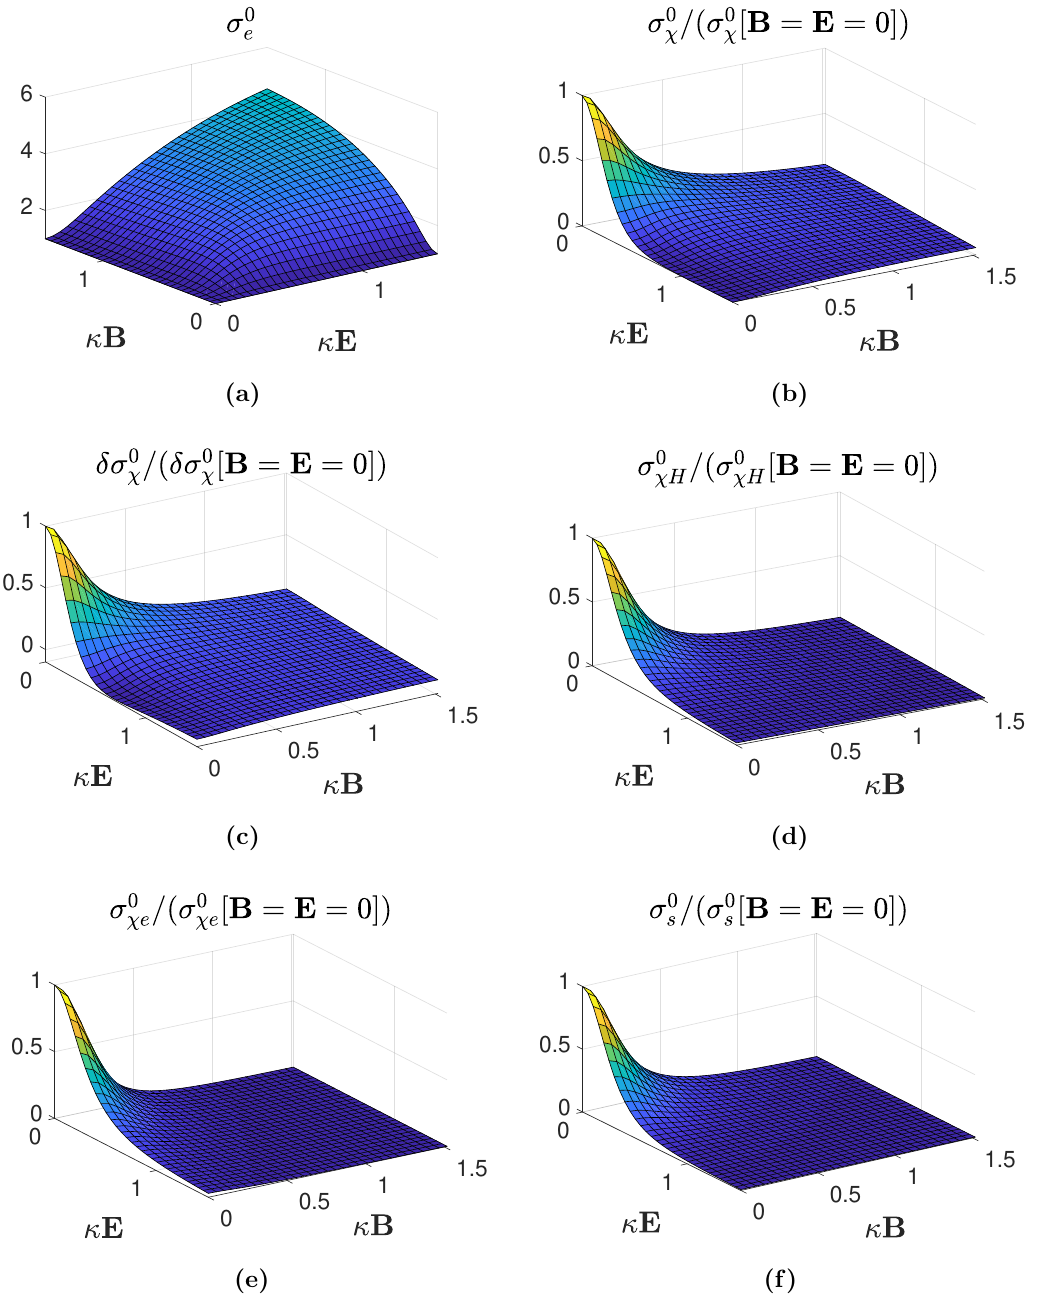
Figure 1. Zeroth order TCs as functions of E and B when ~ E k ~ B